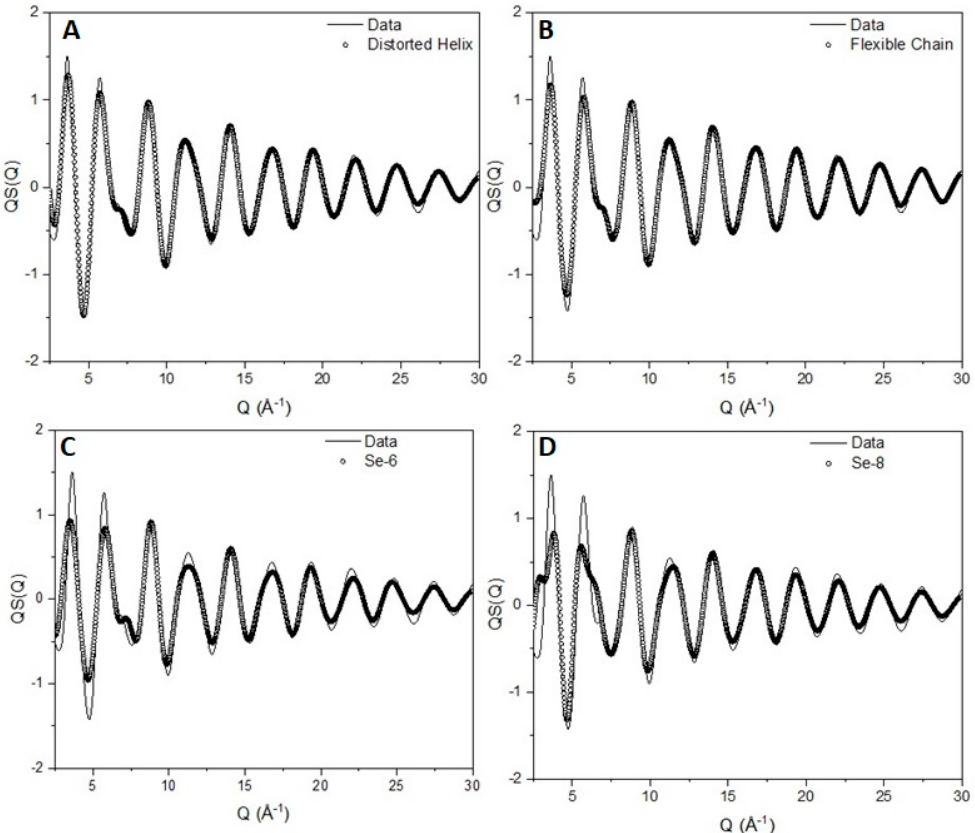
Figure 11. Comparison between the experimentally obtained structure factor (solid line) for vitreous selenium and the scattering pattern obtained from a model of ( A ) a distorted helix, ( B ) a flexible chain, ( C ) six-member rings and ( D ) eight-member rings (open circles).